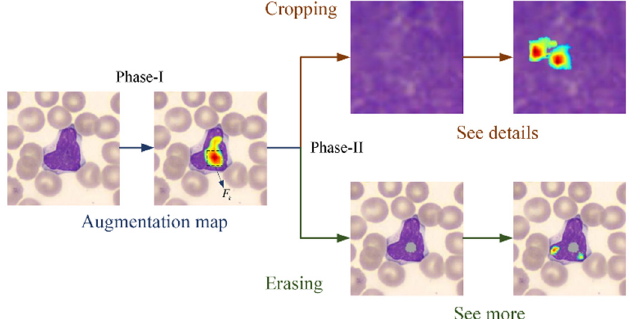
Figure 4. Attention maps represent discriminative parts of the object. The regions with high-attention coefficients are cropped and up-sampled to extract more detailed part features for “see details”. The remaining regions after erasing the regions with high attention are used to generate more discriminative object parts for “see more”.